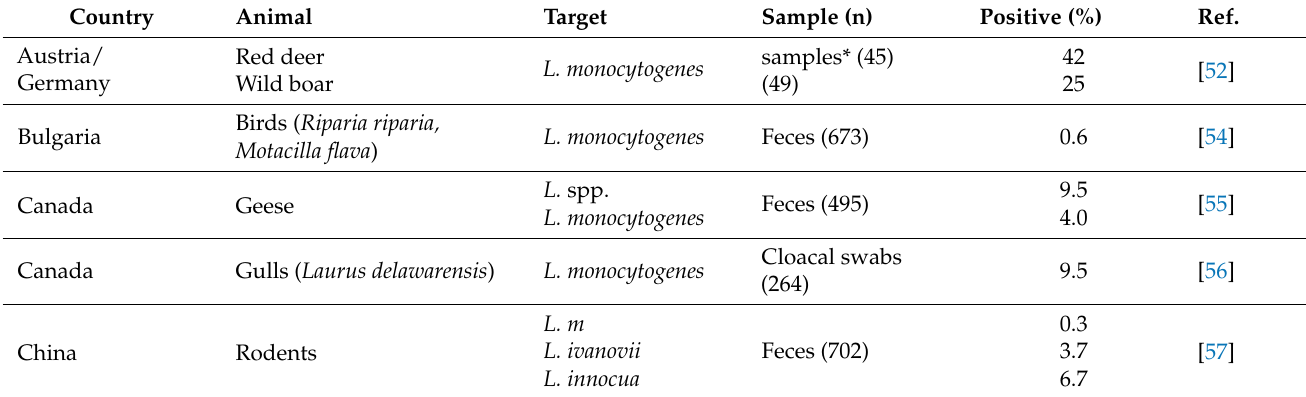
Table 2. Isolation of Listeria monocytogenes from healthy wild